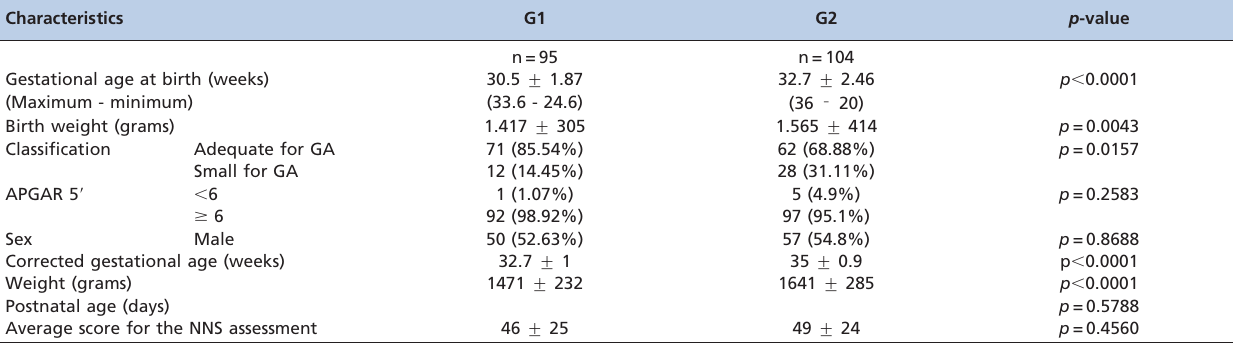
Table 1 - Characteristics of infants at birth and at the 1 st assessment according to group classification. Characteristics